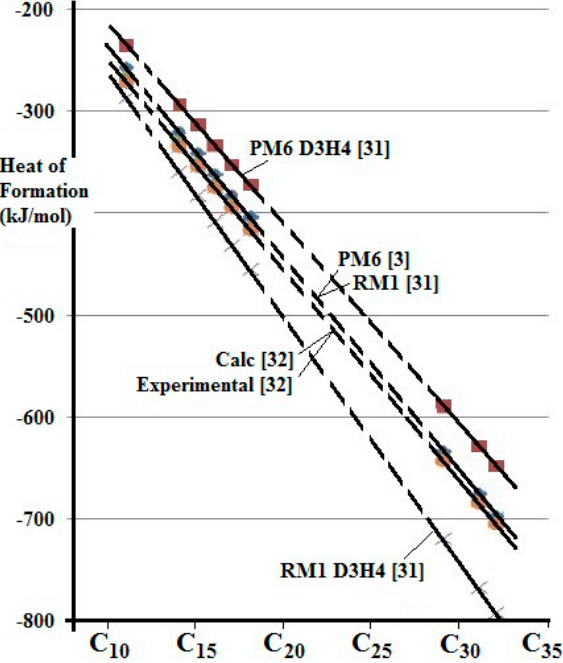
Figure 3. The variation of Heat of Formation for n-alkanes from C 11 to C 32 calculated using AMPAC 10 [31] and compared with earlier calculations and the experimental data [32].